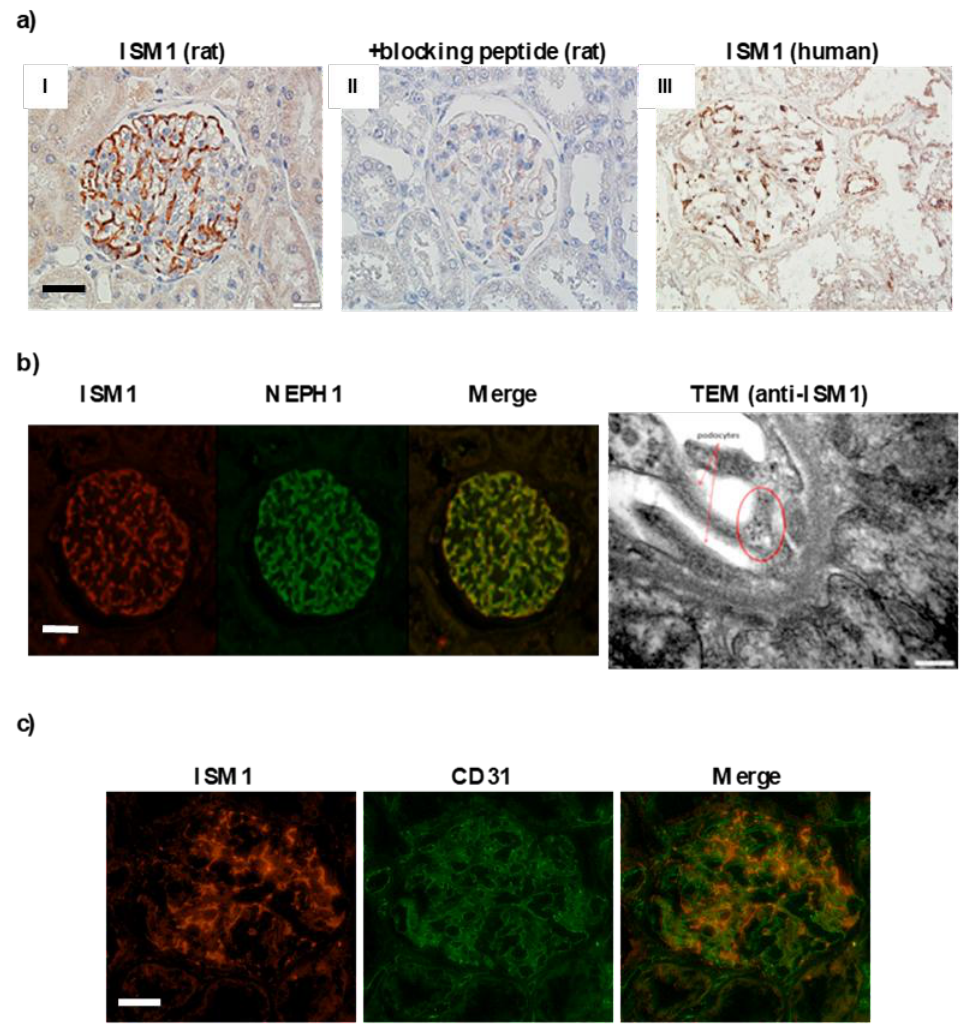
Figure 3. Physiological expression of ISM1 in rodents and human kidneys. ( a ) Glomerular expression of ISM1 in kidney from rats ( I , II ) and human ( III ). ISM1 is expressed exclusively in podocytes. ( b ) ISM1 expression is localized in podocytes. Immunofluorescence showing colocalization between ISM1 and nephrin. Immunogold electron microscopy: ISM1 is localized in the cytoplasm (circled in red) and in the foot process of podocytes (red arrow). ( c ) ISM1 colocalized poorly with the endothelial cell marker CD31. Bar = 10 μm and 400 nm for TEM. ISM1 expression was also explored in different rodent models of glomerulopathy: